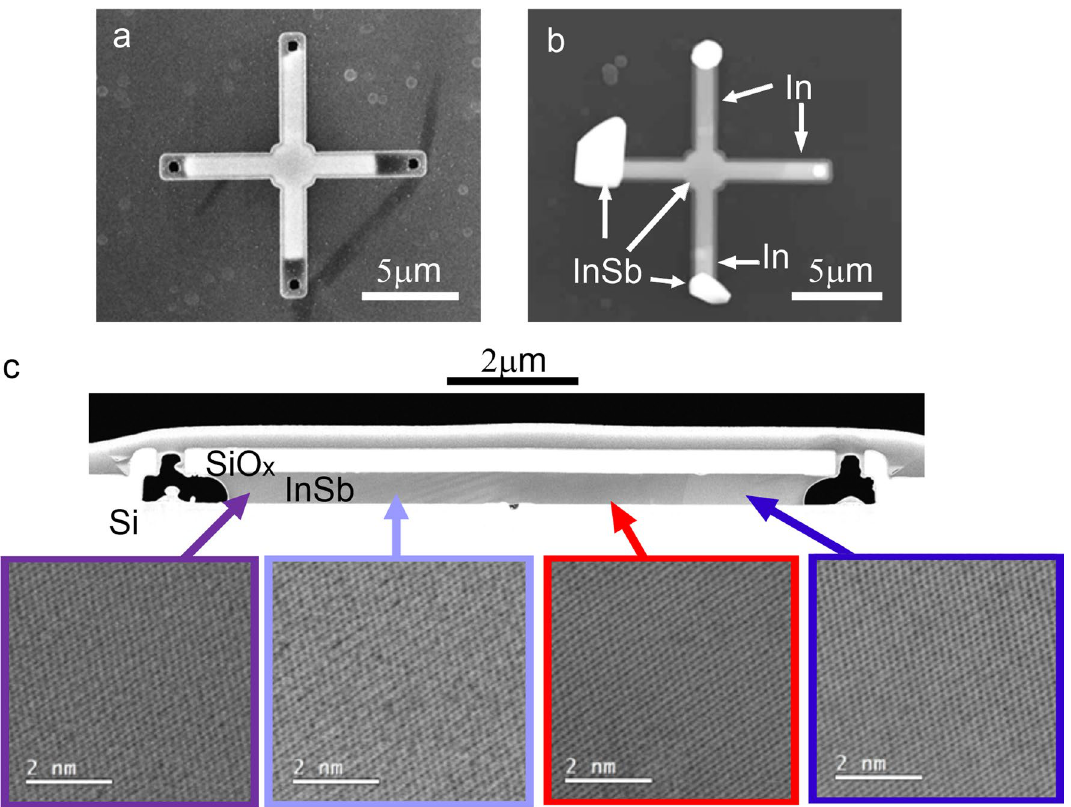
Fig. 6 Analysis of In electrodeposit saturated with Sb at 480 °C. a Top-view SEM image showing uniform contrast of the InSb cross-structure. b A structure with clogged channels, revealing segments of In (bright) and InSb (darker) intensity. c BF-TEM overview of an InSb sample and corresponding high-resolution lattice